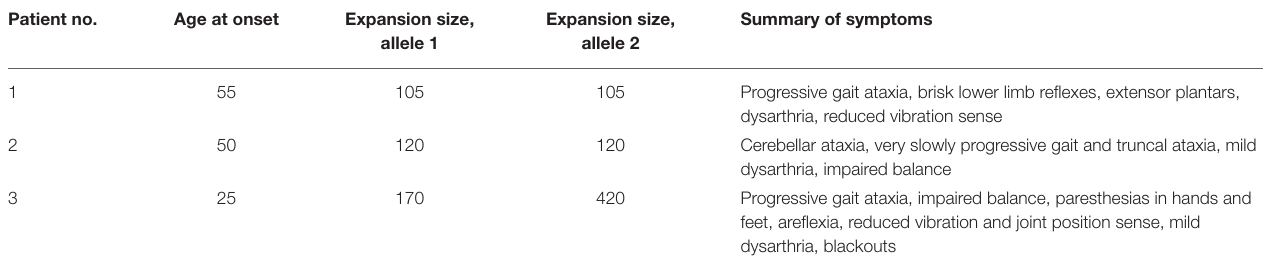
TABLE 1 | Summary of the age at onset, GAA triplet repeat expansion sizes and clinical features for all FRDA positive samples in group A. Patient